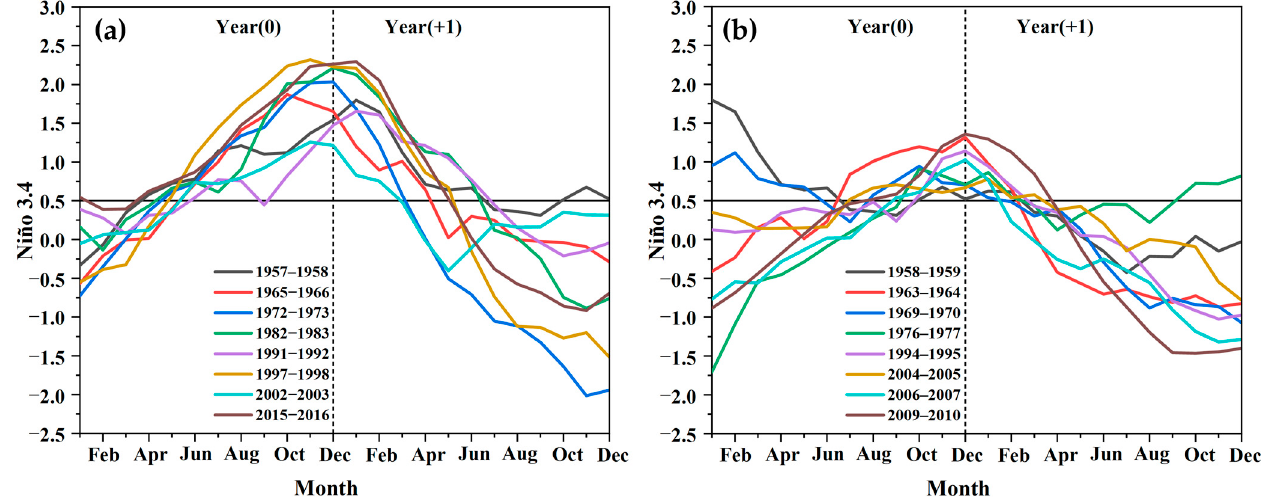
Figure 1. The Niño3.4 indices from the developing year to the decaying year of ( a ) SP El Niño events and ( b ) SU El Niño events. The El Niño developing and decaying years are denoted by year (0) and year (+1), respectively.